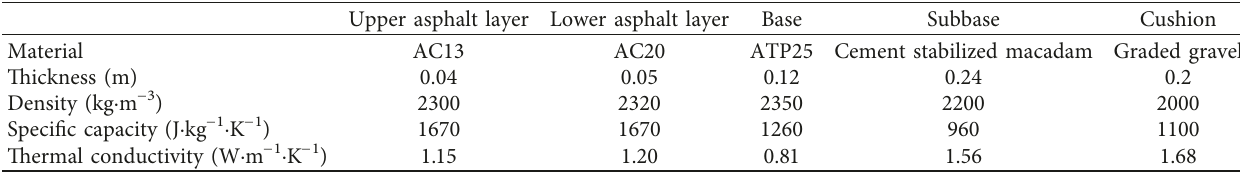
Table 4: Pavement structure and material parameters.